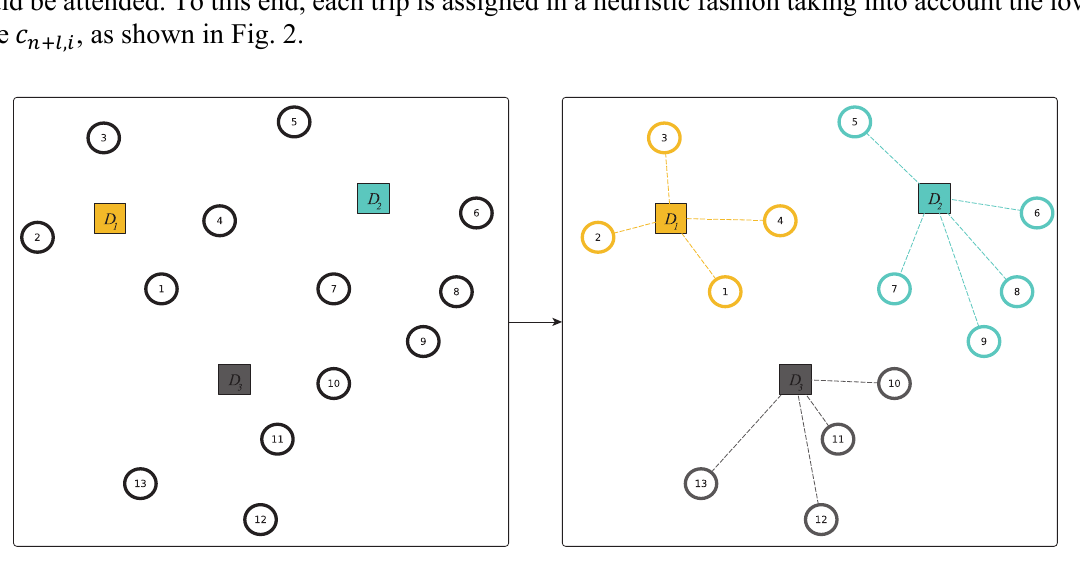
Fig. 2. Clustering of trips for each depot (cid:1830)